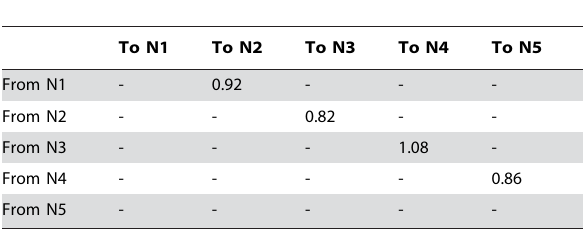
Table 2. Pairwise causal influences using Granger causality following application of significance thresholds, conditional Granger causality analysis, and removal of mediated influences.